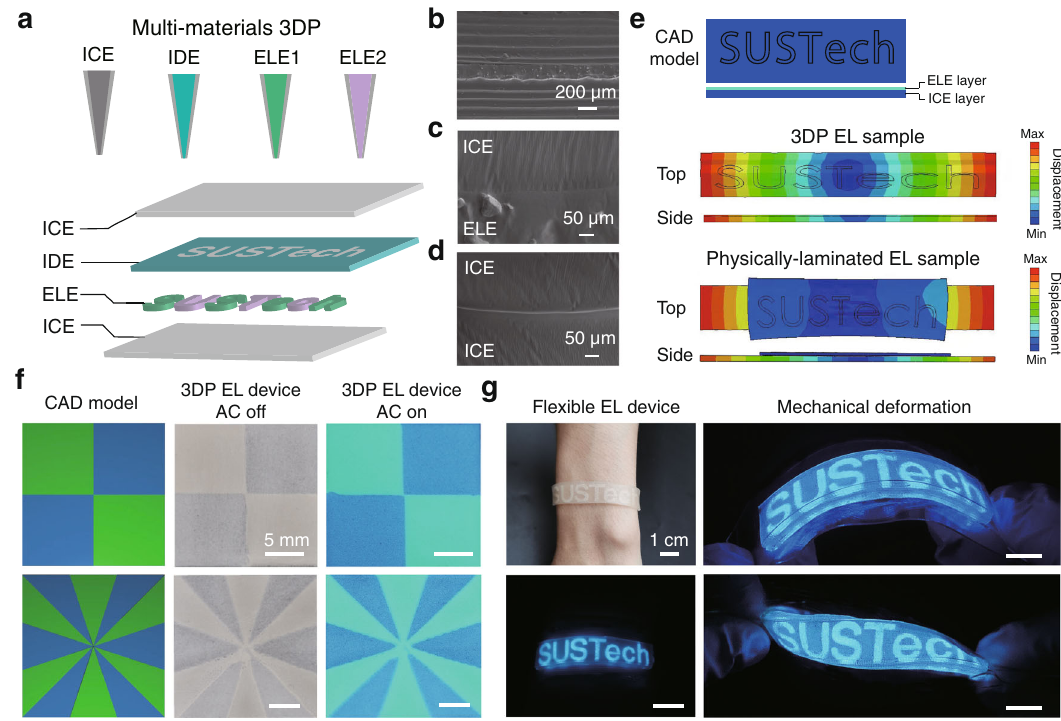
Fig. 3 | Multi-functional 3D printing. a Schematic illustration of the multi- materialDIWprocessforfabricatingELdevices.ICE,IDEandELEInkswereprinted sequentially. b – d SEM images of the multi-layer structure of the 3DP samples ( b ), theinterfacebetweentheICEandELElayers( c ),andtheinterfacebetweentwoICE layers ( d ) of the 3DP samples.Scale bar:200 μ m ( b ) and 50 μ m ( c , d ). e Simulated displacement distributions within the 3DP EL device (top) and a physically- laminated sample (bottom) at an overall applied strain of 35%. Both devices consistedofaELElayer(with “ SUSTech ” logo)andanICElayer.Thesimulationwas